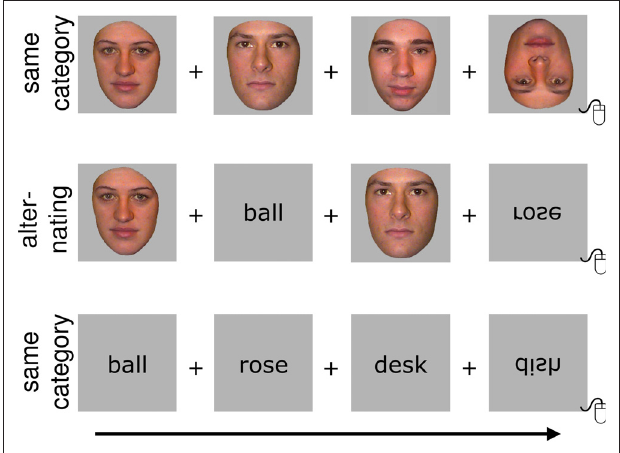
FIGURE 1 | Experimental design. Face and word stimuli were either presented in pure category blocks or in blocks alternating with stimuli from the other category. The task required subjects to press a button whenever a stimulus was presented upside-down